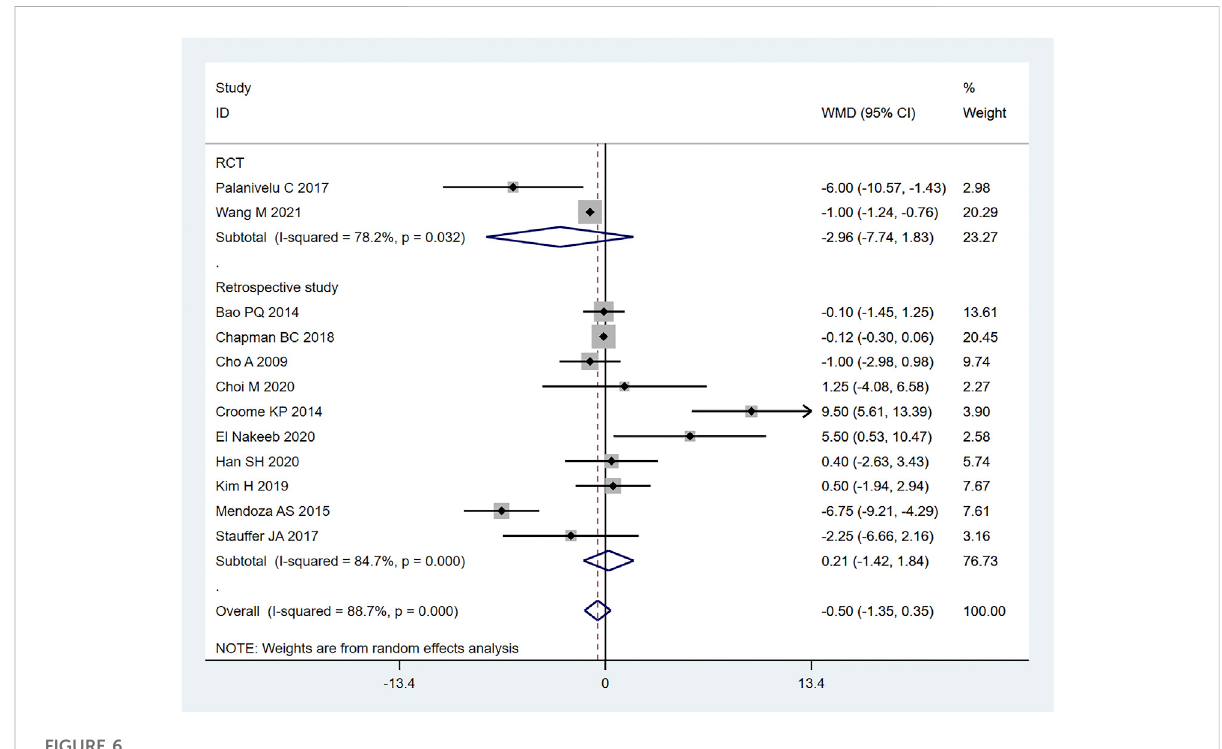
FIGURE 6 Forest plot of Meta-analysis of hospitalization time.